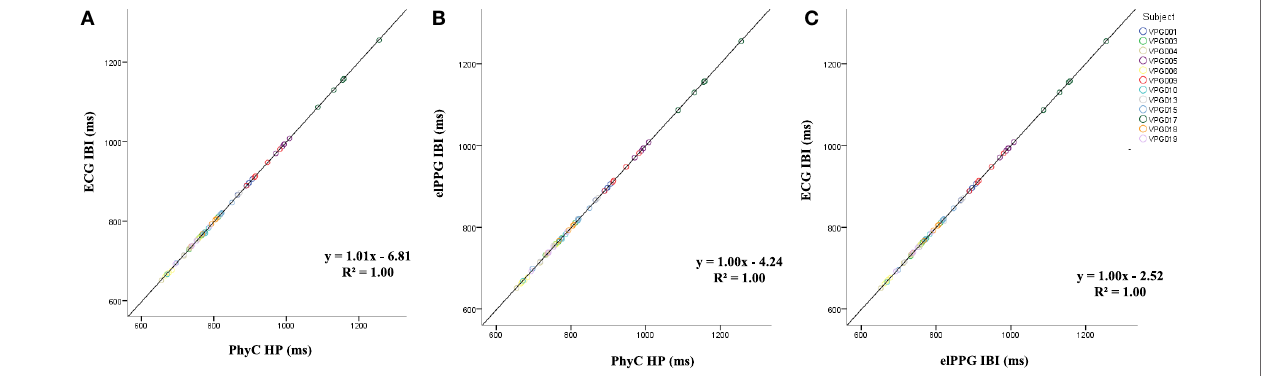
FigUre 7 | Scatter plots between sensors for heart period (HP), color coded by participant. (a) PhysioCam (PhyC) vs electrocardiogram (ECG). (B) PhyC vs elPPG. (c) elPPG vs